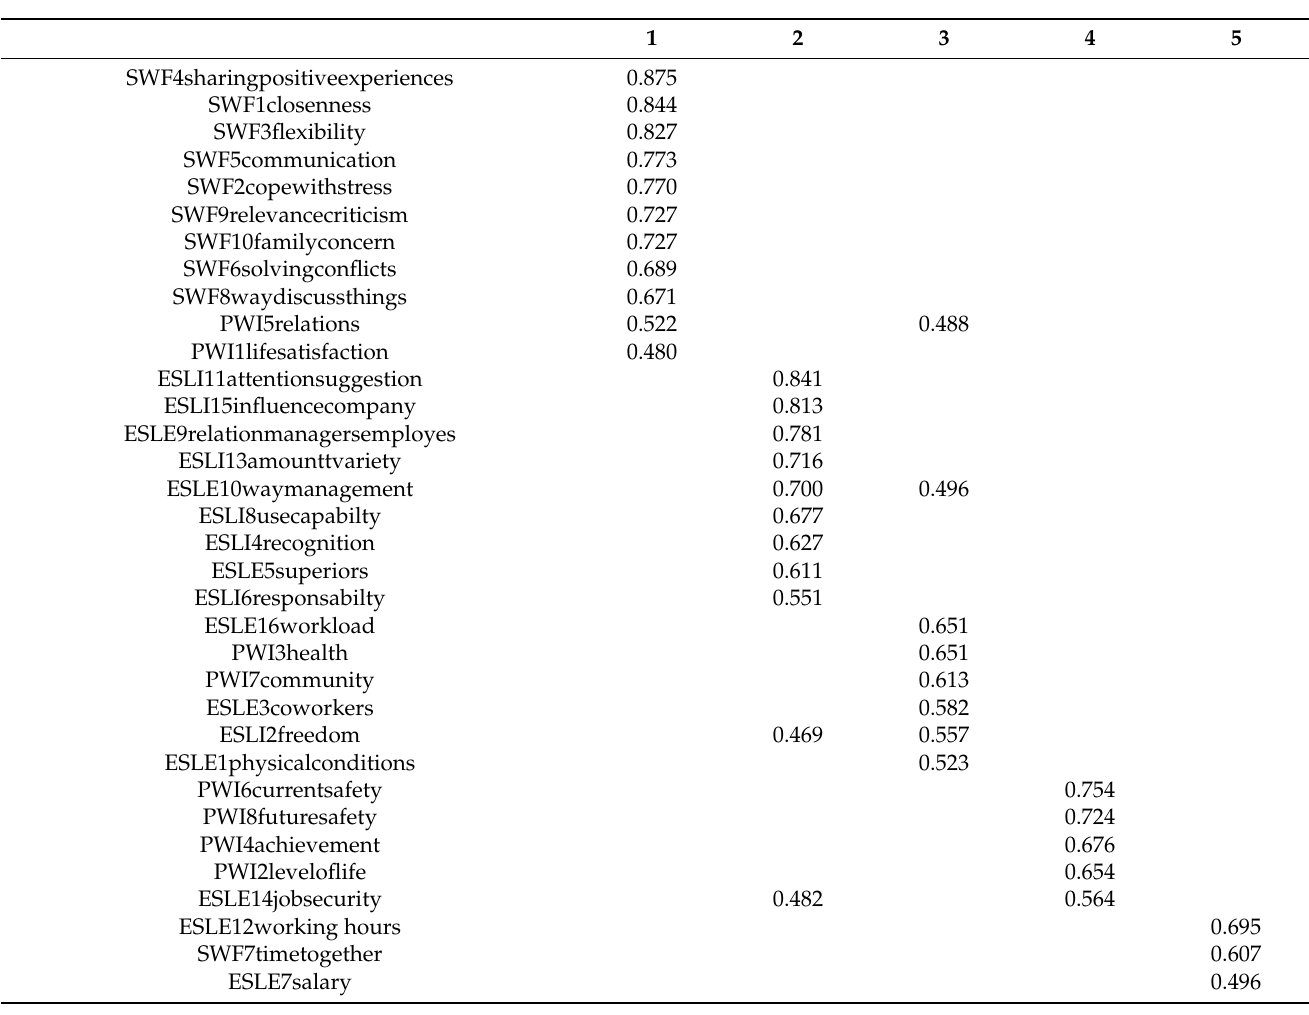
Table A4. Rotated Component